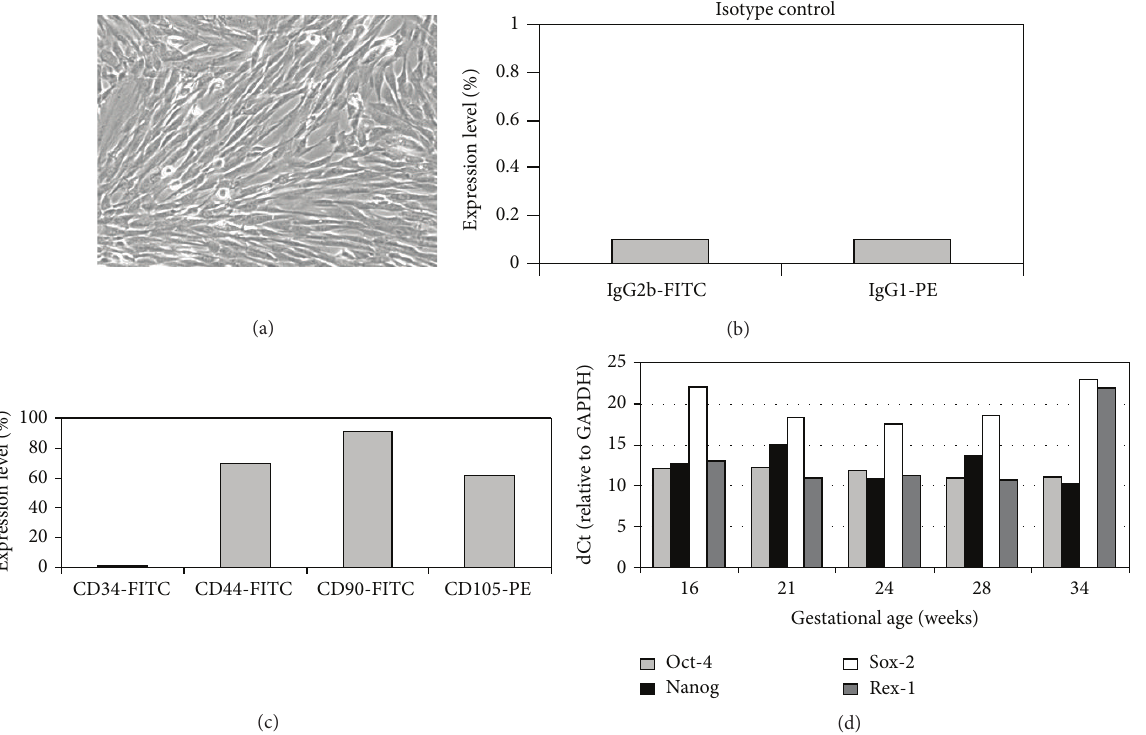
Figure 2: Phenotypical characteristics of AF-MSCs from late trimesters. (a) Representative image of spindle-shaped MSCs at passage 4. (b) Expression of cell surface markers from representative FACS histograms of isotype negative controls and (c) AF-MSCs gated for CD34, CD44, CD90, and CD105. (d) The relative expression of pluripotency markers Oct-4, Nanog, Sox-2, and Rex-1 in AF-MSCs populations obtained from amniocentesis samples of second- and third-trimester at passages 4–6 by RT-qPCR. The expression of mRNA was normalized to